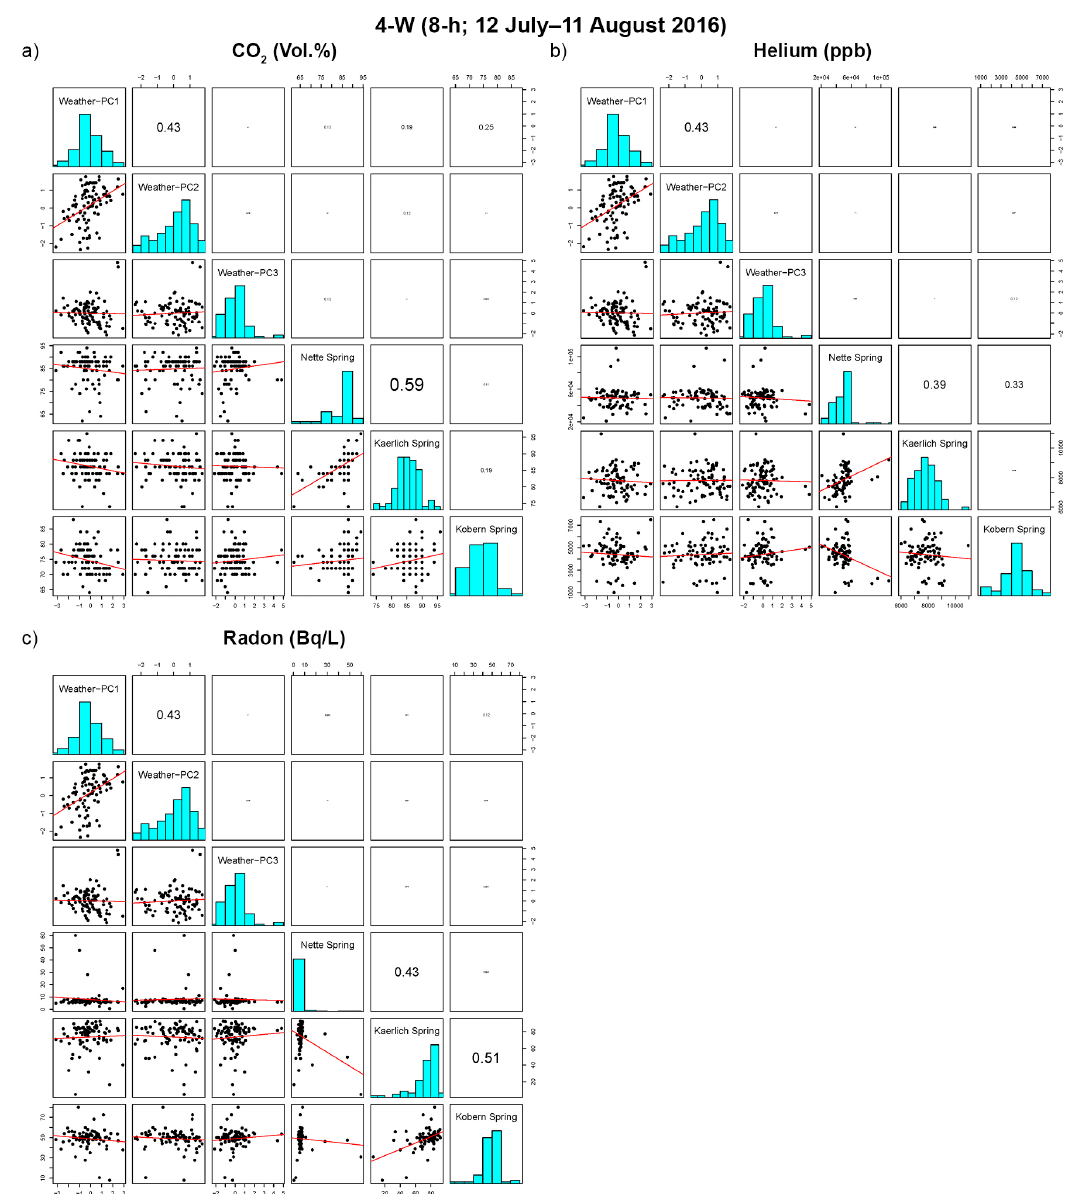
Figure A2. Coefficients of the principal components analysis of weather variables with geogenic gas concentrations for ( a ) CO 2 , ( b ) He, and ( c ) Rn for the mineral springs during the 4-W campaign. The histograms on the diagonal illustrate the distribution of data of each of the three principal axes describing meteorological conditions (see also Tables 2 and 3); the plots below the diagonal illustrate the raw data (symbols) and pair-wise linear regression relationships (red lines) for each corresponding pair of variables along the diagonal, and the panels above the diagonals report the pair-wise correlation coefficients (font size scaled to the coefficients).